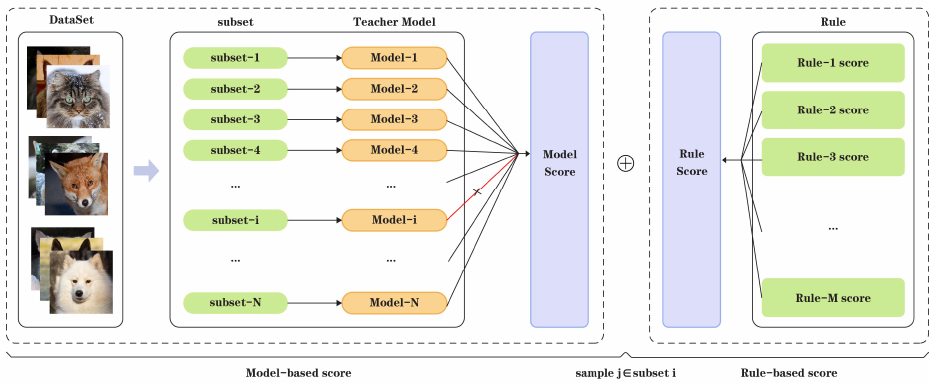
Figure 4. Visualization of the cross-review difficulty evaluator.